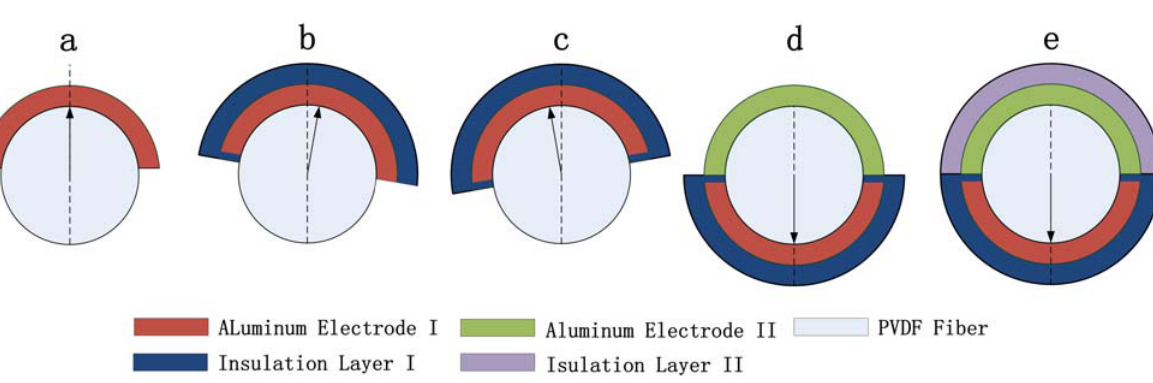
Figure 10. Detailed processing sequence of PVDF micro/nano fibers fabrication; (a) evaporation of the first aluminum, (b-c) by swinging the substrate along the fiber axis, the insulation layer covers the metal electrode completely, (d) fiber inverted in order to